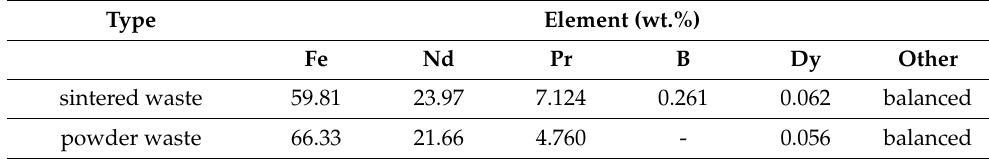
Table 1. Chemical composition of manufacturing NdFeB magnet wastes analyzed by ICP-OES.